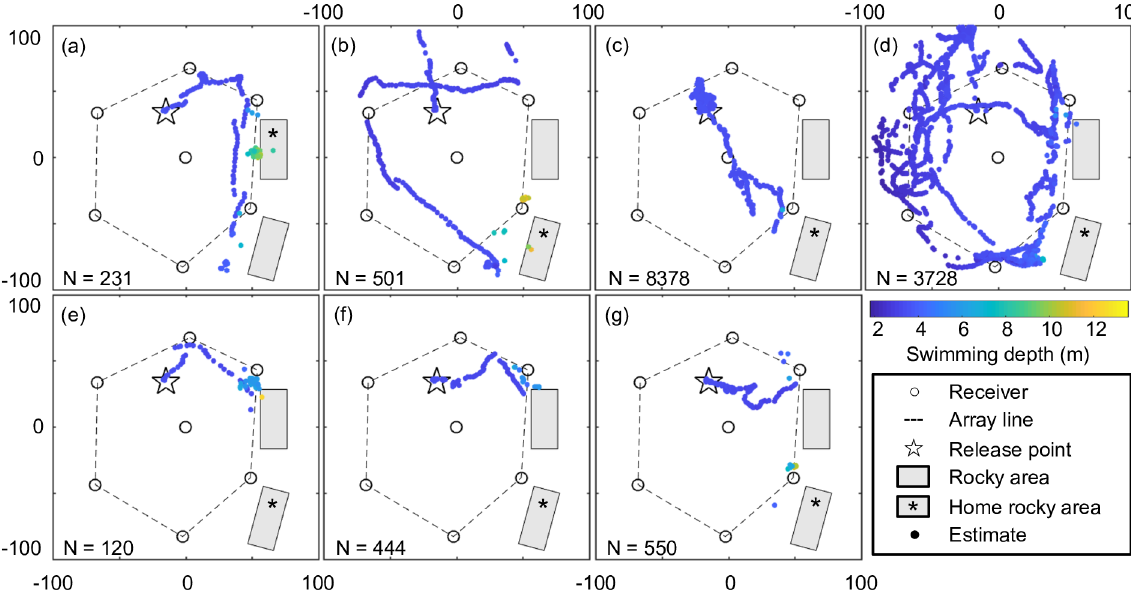
Fig 6. 3D estimates of seven tagged Siebold’s wrasses (F1 − 7) during the monitoring period. Estimates for F1 − 7 are shown in (a) − (g), respectively, with colour variations indicating swimming depths.